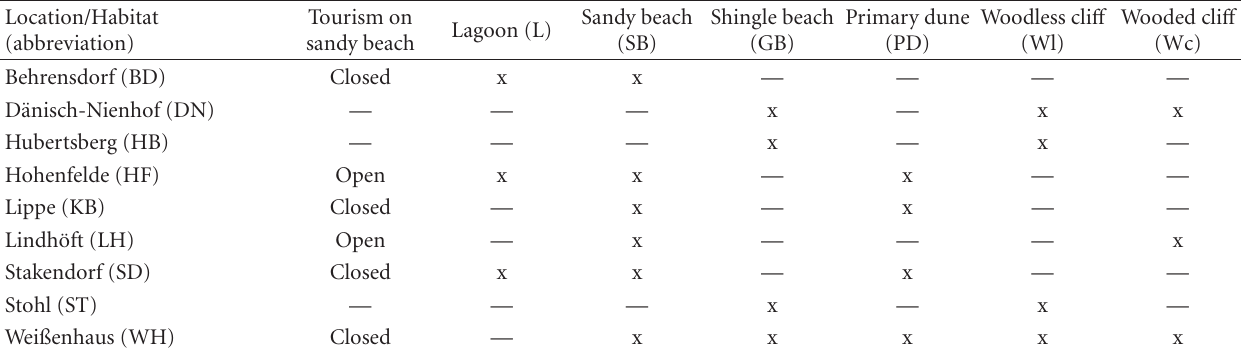
Table 1: Habitats at the investigated locations and abbreviations of locations and habitats; x indicates a number of 4 replicate pitfall traps. Location/Habitat